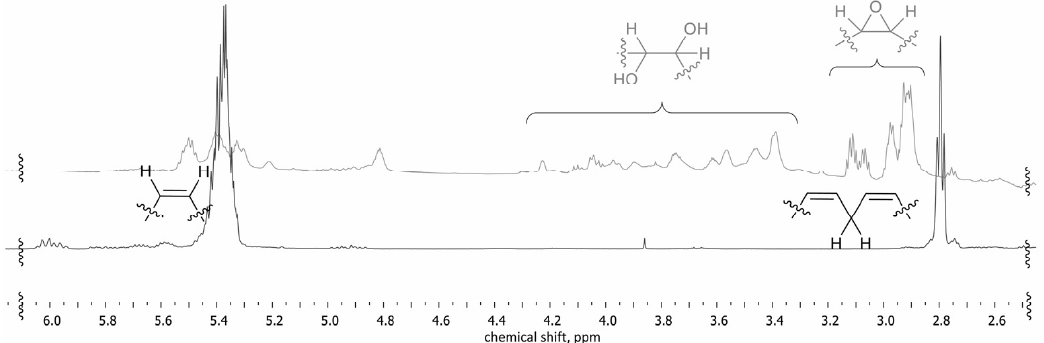
Figure 6. 1 H-NMR of TOFA and E IR TOFA (500 MHz, CDCl 3 ).